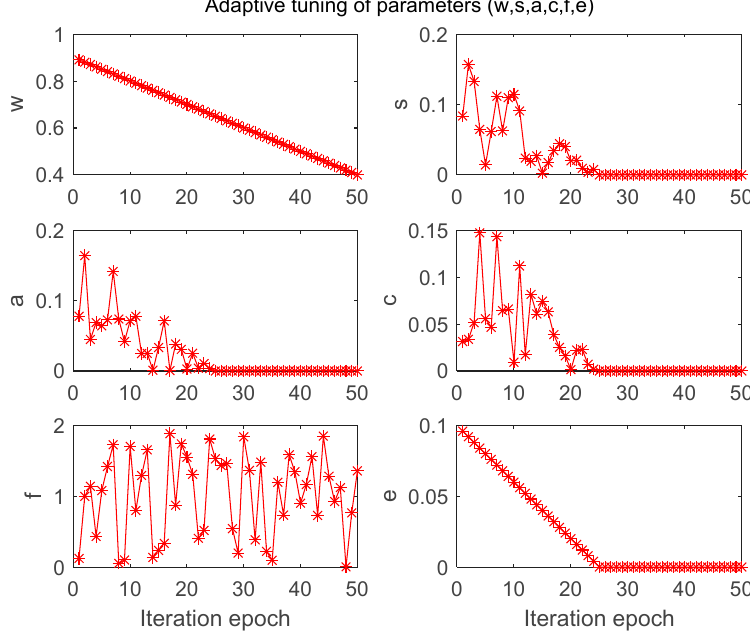
Figure 8. Adaptive tuning of parameters (w, s, a, c, f, e).